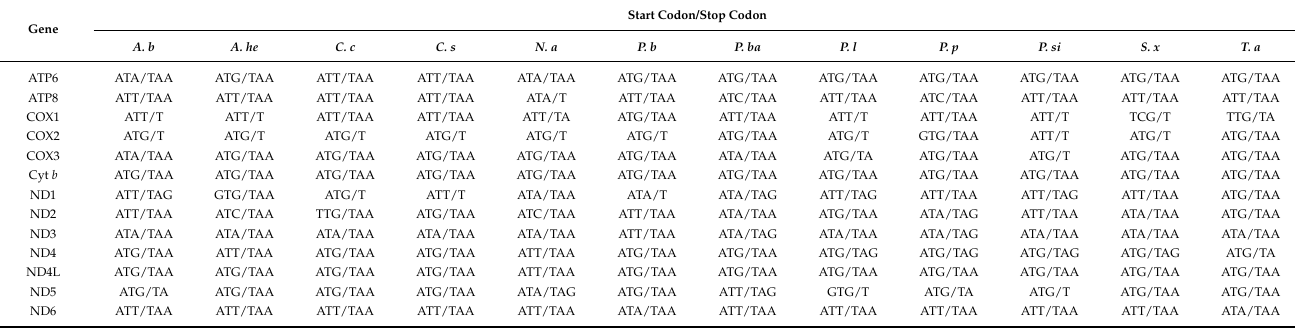
Table 5. Start and stop codons of the Microcoryphia mitochondrial genomes. Notes: Allopsonsu baii ( A. b ); Allopsonsus helanensis (A. he) ; Coreamachilis coreanus (C. c) ; Coreamachilis songi (C. s) ; Nesomachilis australica (N. a) ; Petrobius brevistylis (P. b) ; Petrobiellus bannaensis (P. ba) ; Pedetontinus luanchuanensis (P. l) ; Petrobiellus puerensis (P. p) ; Pedetontus silvestrii (P. si) ; Songmachilis xinxiangensis (S. x) ; Trigoniophthalmus alternatus (T. a)